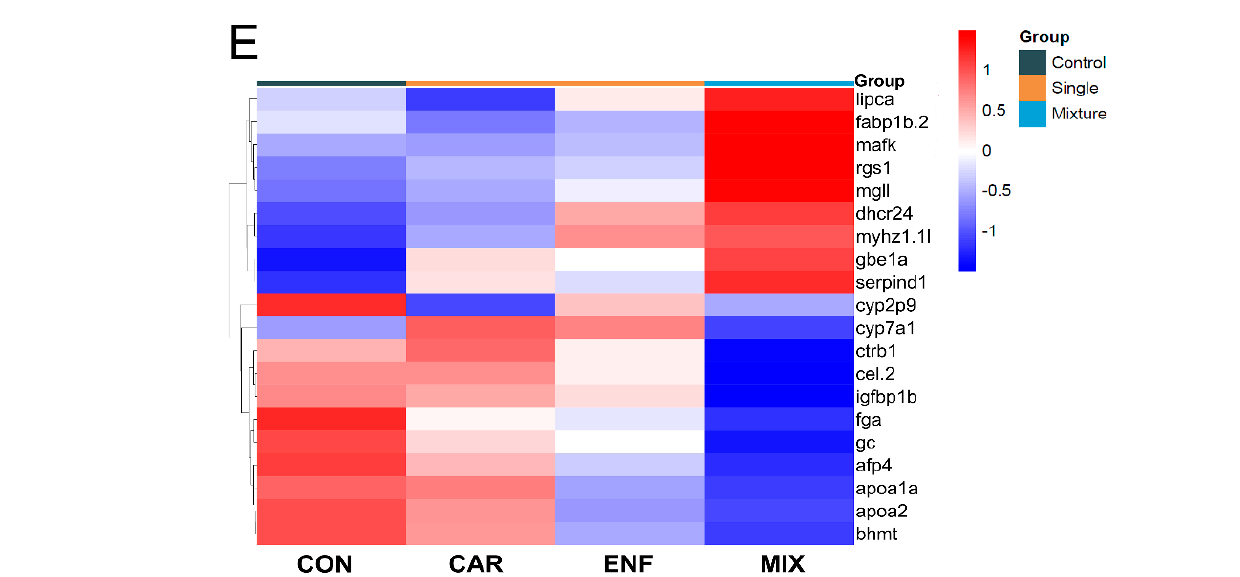
Figure 5. Transcriptomic results indicate that DEGs among treatment groups are enriched in genes required for nutrient metabolism. ( A ) DEGs for controls vs. MIX, CAR vs. MIX, and ENF vs. MIX at 96 hpf. ( B ) KEGG pathway enrichment of DEGs. The y-axis represents the significantly enriched KEGG pathways and the x-axis denotes the enrichment factor of DEGs. ( C ) GO category pattern of DEGs in 96 hpf larvae. ( D ) GO network of DEGs. ( E ) Heat map of top DEGs.